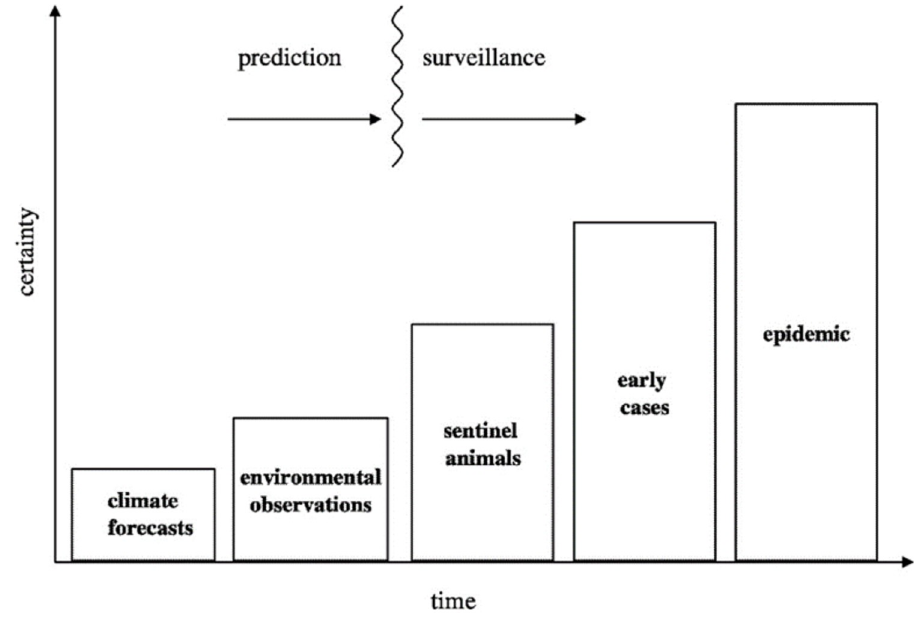
Fig 10. Progressive scale of surveillance that can used to indicate an impending RVFV disease outbreak. Republished with permission of The National Academies Press, from Under the Weather: Climate, Ecosystems, and Infectious Disease (2001), Chapter 7: Towards the Development of Disease Early Warning Systems. P. 87; permission conveyed through Copyright Clearance Center, Inc. under license ID